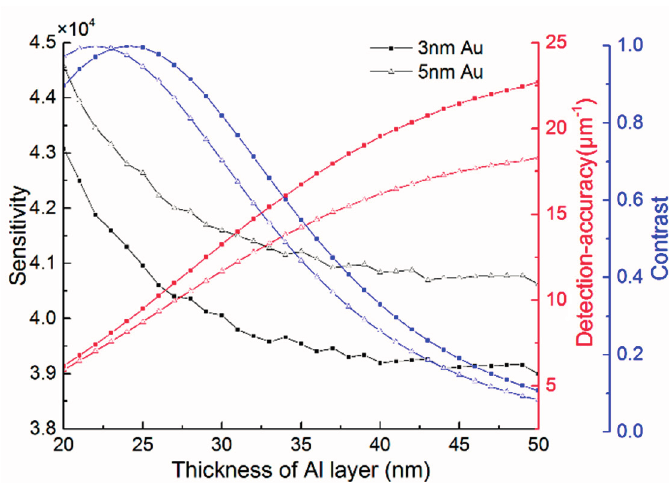
Figure 9. The influence of the thickness of Al layer in the bimetallic SPR sensor with 3 nm or 5 nm Au.